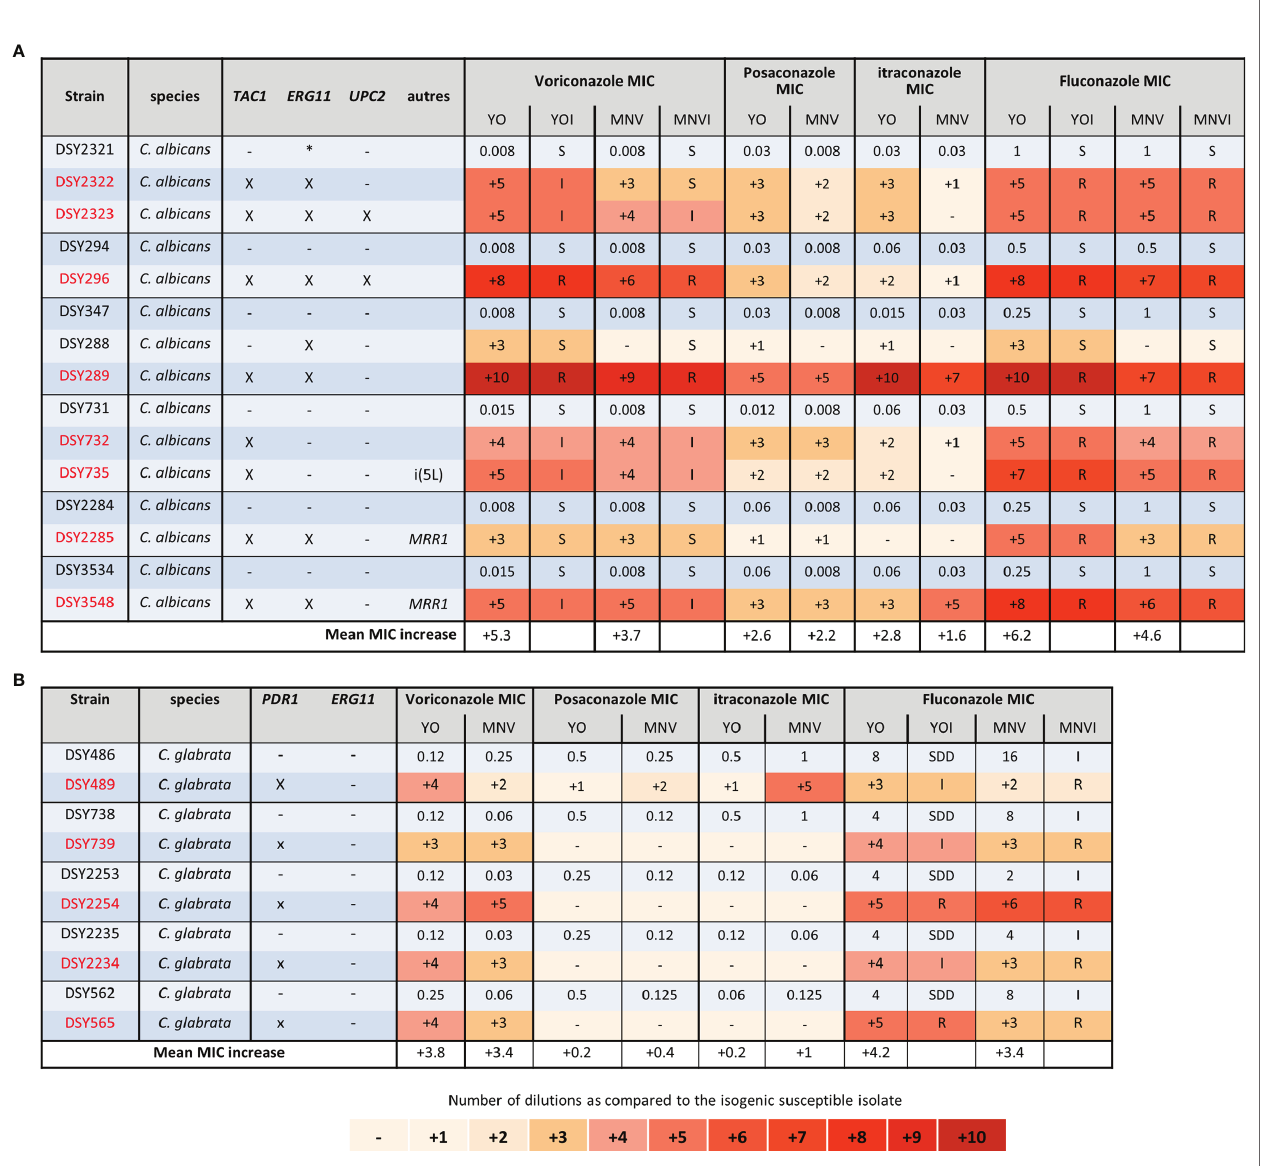
FIGURE 3 | Azole MIC increases of C. albicans and C. glabrata resistant strains as compared to matched susceptible ones for YO and MNV. (A) C. albicans matched strains. (B) C. glabrata matched strains. For all susceptible isolates, the MIC values are indicated in micrograms per millilliter of drugs, whereas for the matched resistant isolates, the respective number of azole dilutions to reach the MIC is indicated. When possible, the interpretation of the MIC, relative to existing breakpoints, is indicated in the YOI (for YO) and MNVI (for Micronaut-AM)